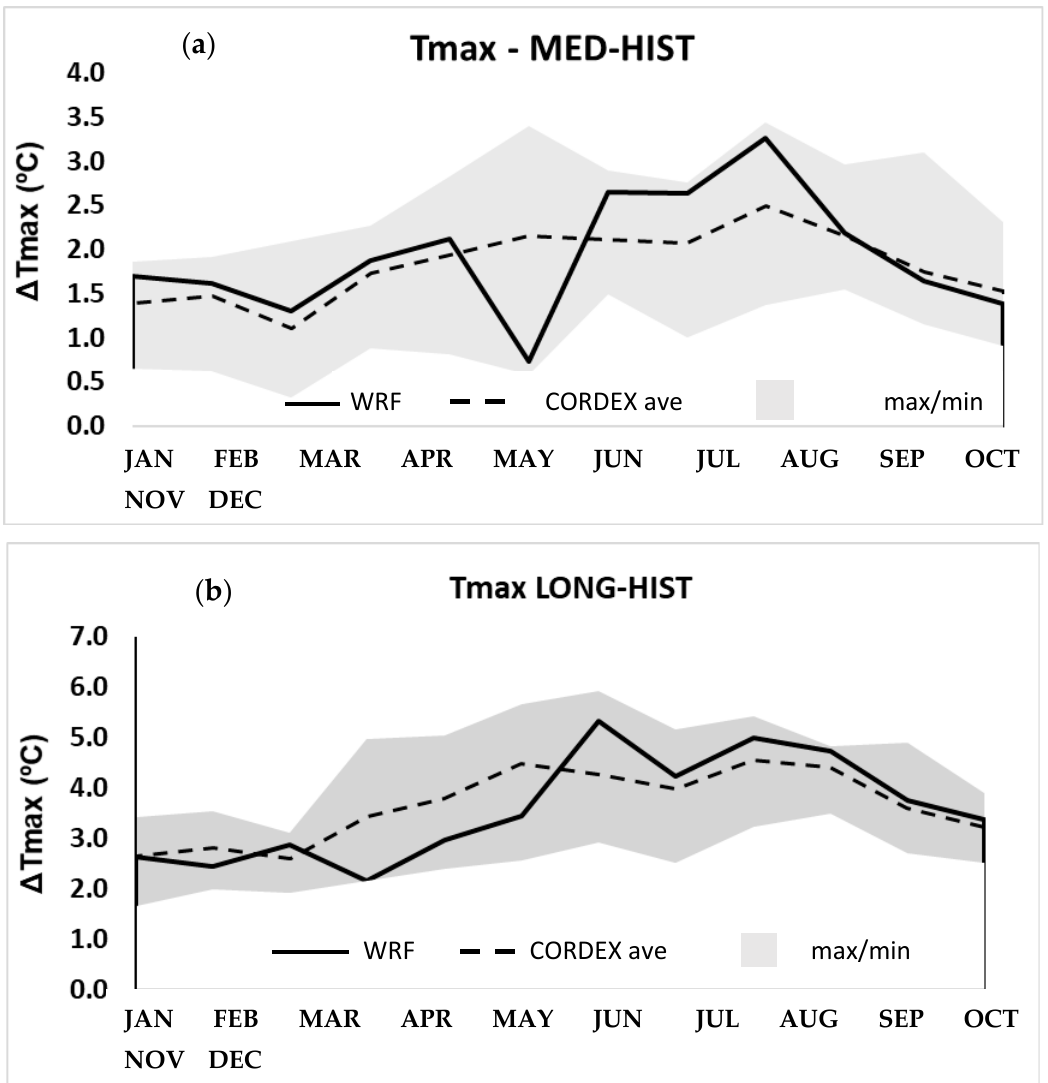
Figure 7. Monthly differences relative to HIST of Tmax for ( a ) MED and ( b ), for WRF and average, maximum and minimum CORDEX models. MED: Simulation for the 2046–2065 period where the WRF was forced by the MPI model considering the RCP8.5 scenario.